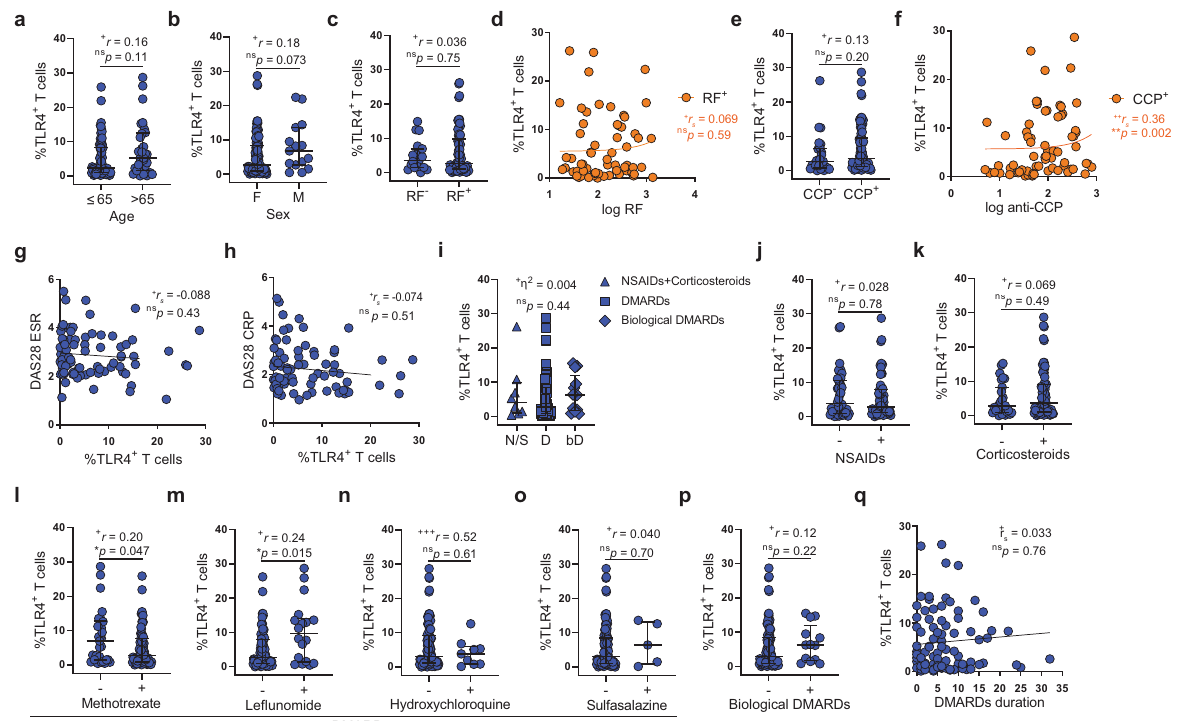
Fig. 4 The frequency of TLR4 + T correlates with anti-CCP antibody titers and age, independently of treatment. a Frequency of TLR4 + T cells disaggregated by age (n = 101 RA patients; ≤ 65 years n = 64; >65 years n = 37). b Frequency of TLR4 + T cells disaggregated by sex ( n = 101 RA patients; female n = 86; male n = 15). c Frequency of TLR4 + T cells disaggregated by factor rheumatoid (RF) status ( n = 84 RA patients; RF + n = 65; RF − n = 19). d Correlation between factor rheumatoid titers and frequency of TLR4 + T cells in rheumatoid factor positive patients ( n = 65 RF + RA patients). e Frequency of TLR4 + T cells disaggregated by factor anti-CCP antibody status ( n = 96 RA patients; CCP + n = 71; CCP − n = 25). f Correlation between factor anti-CCP antibody titers and frequency of TLR4 + T cells in CCP-positive patients ( n = 71 CCP + RA patients). g Correlation between frequency of TLR4 + T cells and DAS28 ESR score ( n = 81 RA patients). h Correlation between frequency of TLR4 + T cells and DAS28 CRP score ( n = 81 RA